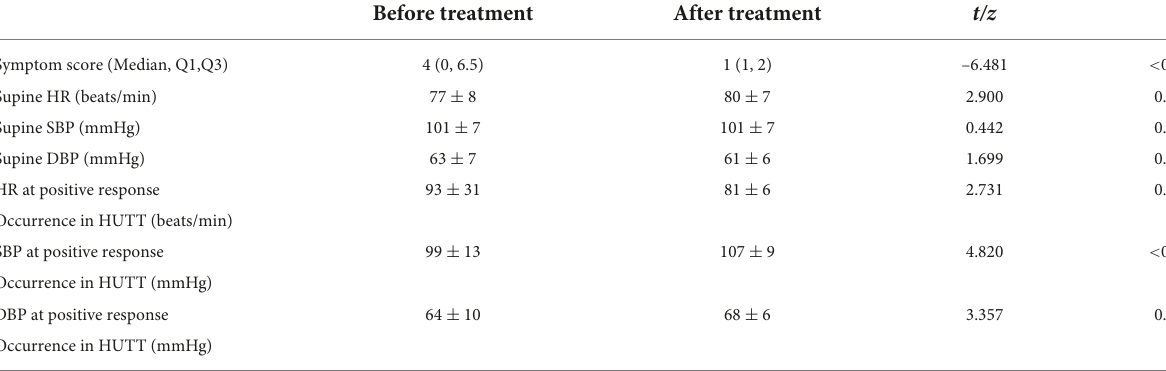
TABLE 3 Analysis of symptom scores and hemodynamic parameters of VVS patients treated by midodrine hydrochloride. Before treatment After treatment Symptom score (Median,